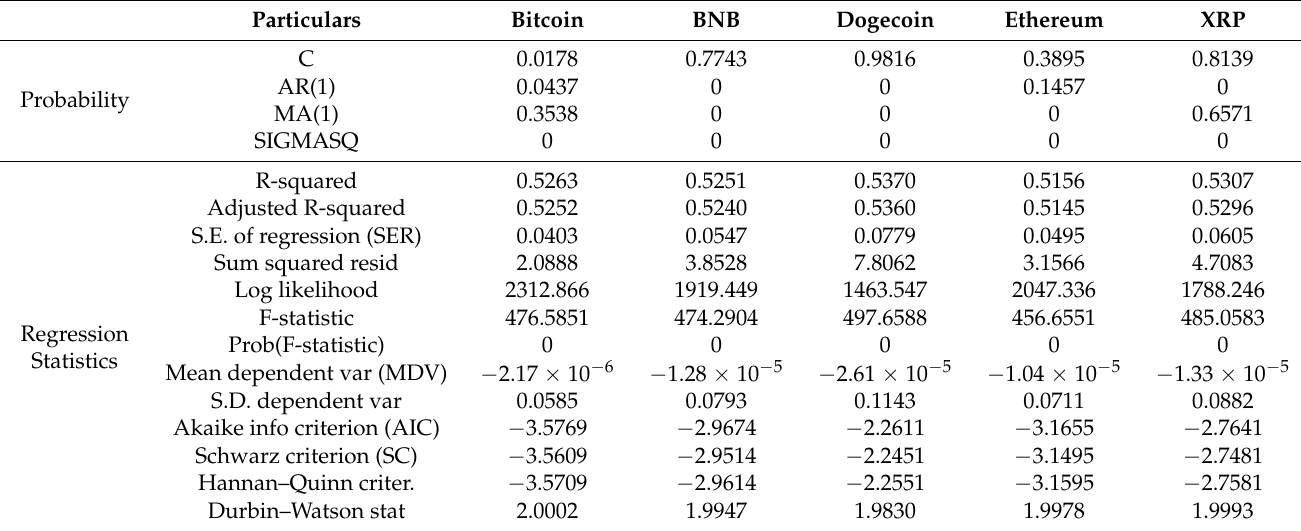
Table 3. ARMA Maximum Likelihood (OPG–BHHH) of Return.